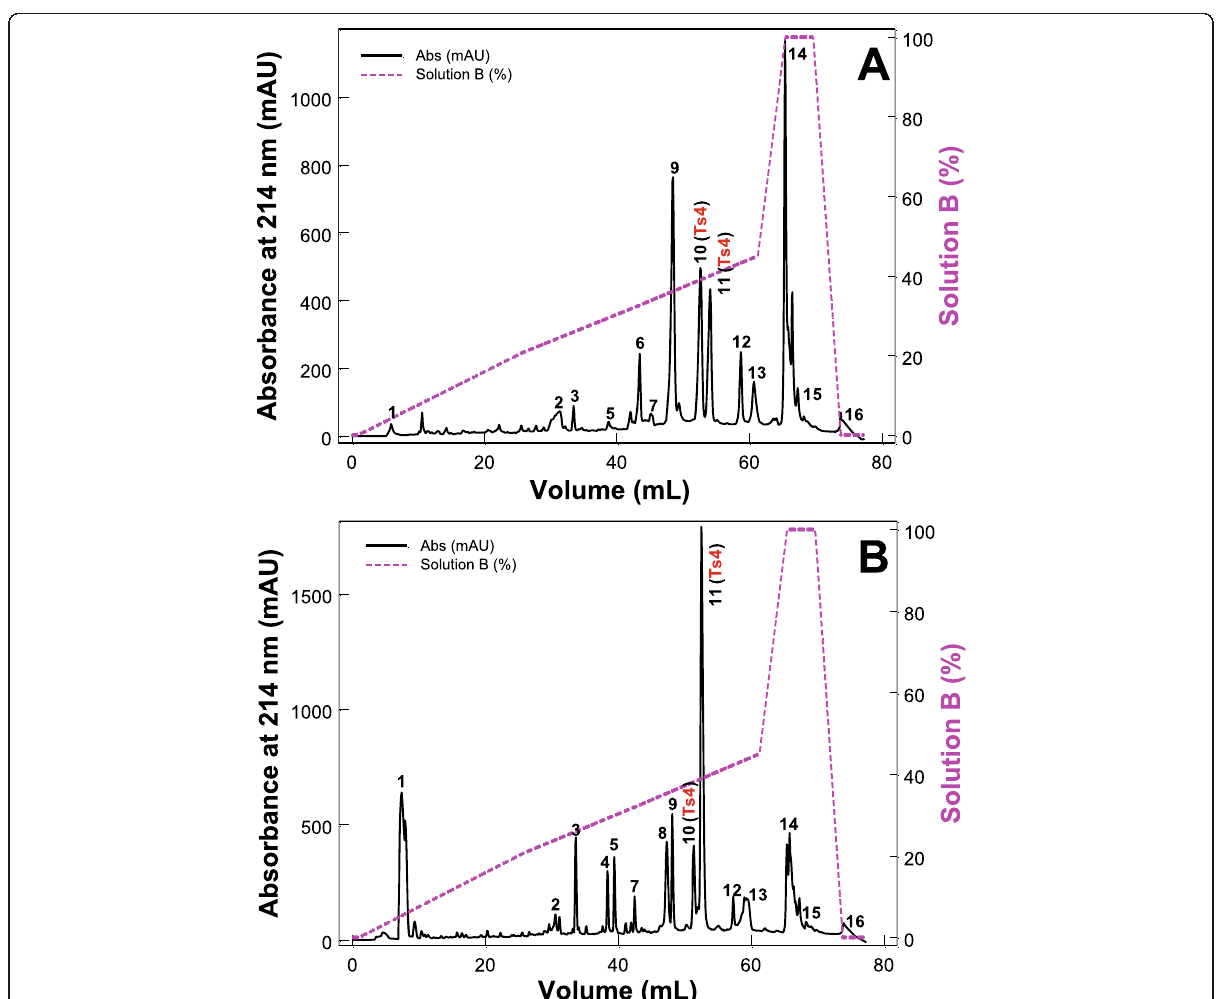
Fig. 1 Chromatographic profiles of fractions VIIIA and VIIIB from Tsv. ( a ) Fraction VIIIA. ( b ) Fraction VIIIB. Fractions (4 mg, eluted of the cation exchange chromatography from Tityus serrulatus venom) were submitted to RP-FPLC on a C18 column (4.6 mm×250.0 mm, 5 μ m particles, Shimadzu Corp.). The column was equilibrated with 0.1 % trifluoroacetic acid (TFA) and the proteins were eluted using a concentration gradient from 0 to 100 % of solution B (80 % acetonitrile (ACN) in 0.1 % TFA), represented by the dashed line. Absorbance was monitored at 214 nm, at 25 °C, using an FPLC Äkta Purifier UPC-10 system. Fractions of 0.3 mL/tube were collected at a flow rate of 0.7